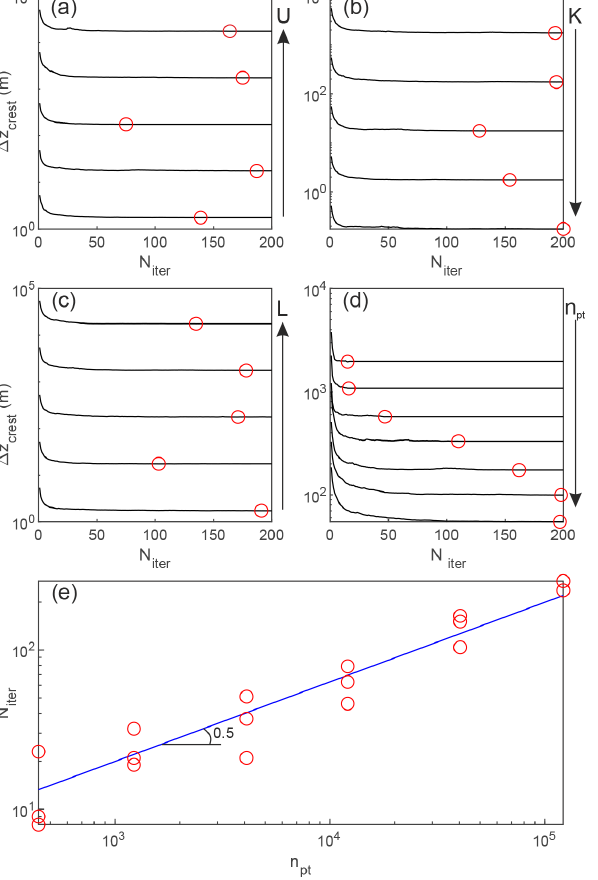
Figure 3. Influence of model parameters and geometry on the con- vergence towards a steady-state landscape. (a) Uplift rate U was varied between 10 − 4 and 1myr − 1 . (b) Erodibility K was varied between 1 × 10 − 7 and 1 × 10 − 3 yr − 1 . (c) Model length L was var- ied between 0.1 and 100km. (d) The number of model points n pt was varied between 1 . 2 × 10 3 and 0 . 4 × 10 6 . (e) The relationship between the number of iterations required to reach steady state and n pt follows a power law with an exponent 0.5 (blue